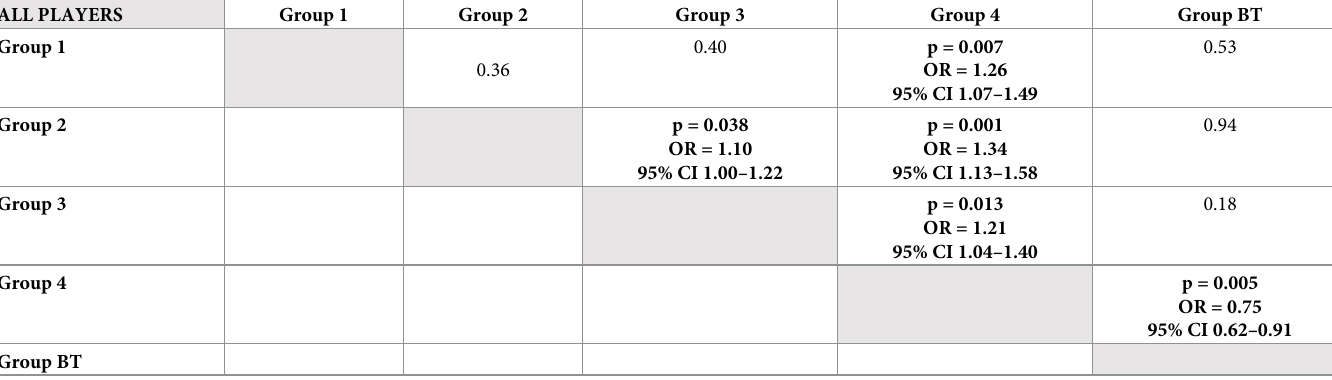
Table 3. Differences between the number of ‘late-born’ players in various groups (p values)—Chi-square. ALL